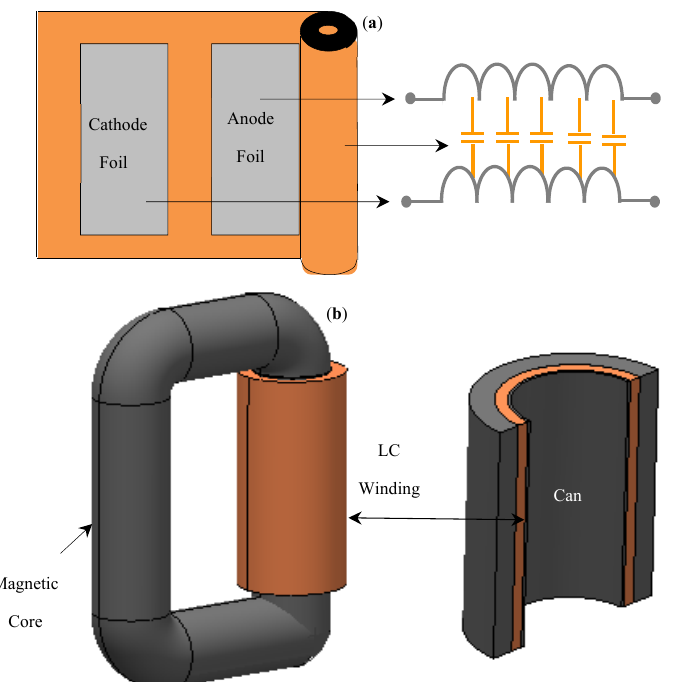
Figure 19. Integrated Filter with LC Windings ( a ) Construction ( b ) 3D View .